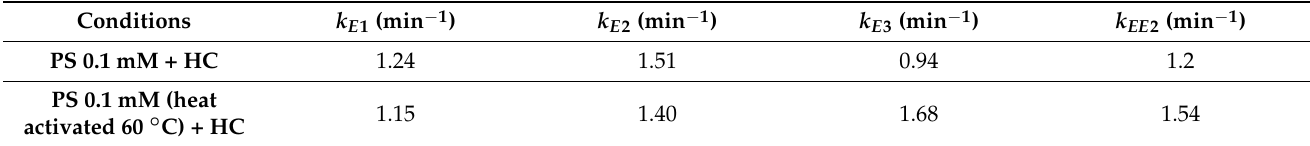
Table 2. The pseudo-first-rate constants of estrogens degradation; r > 0.97.